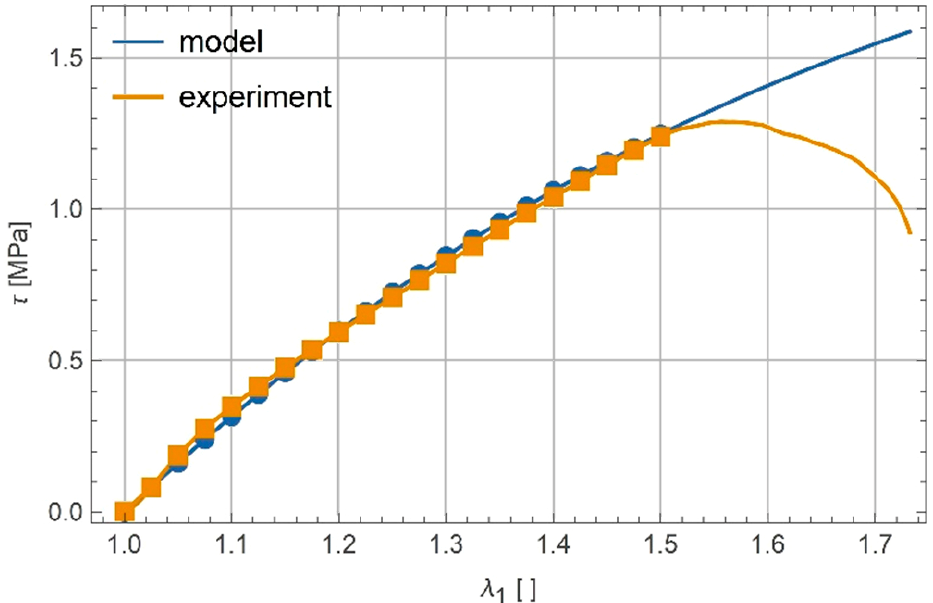
Figure 7. Experimental and calibrated model response for shear.